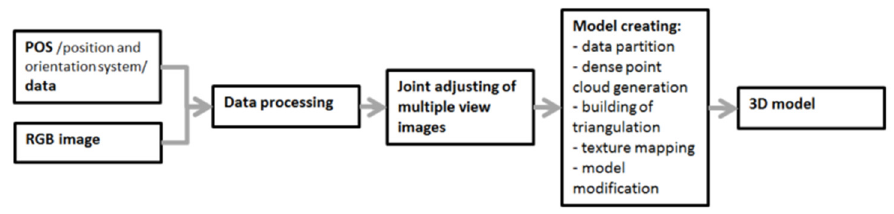
Figure 13. Process of oblique photogrammetry modeling.